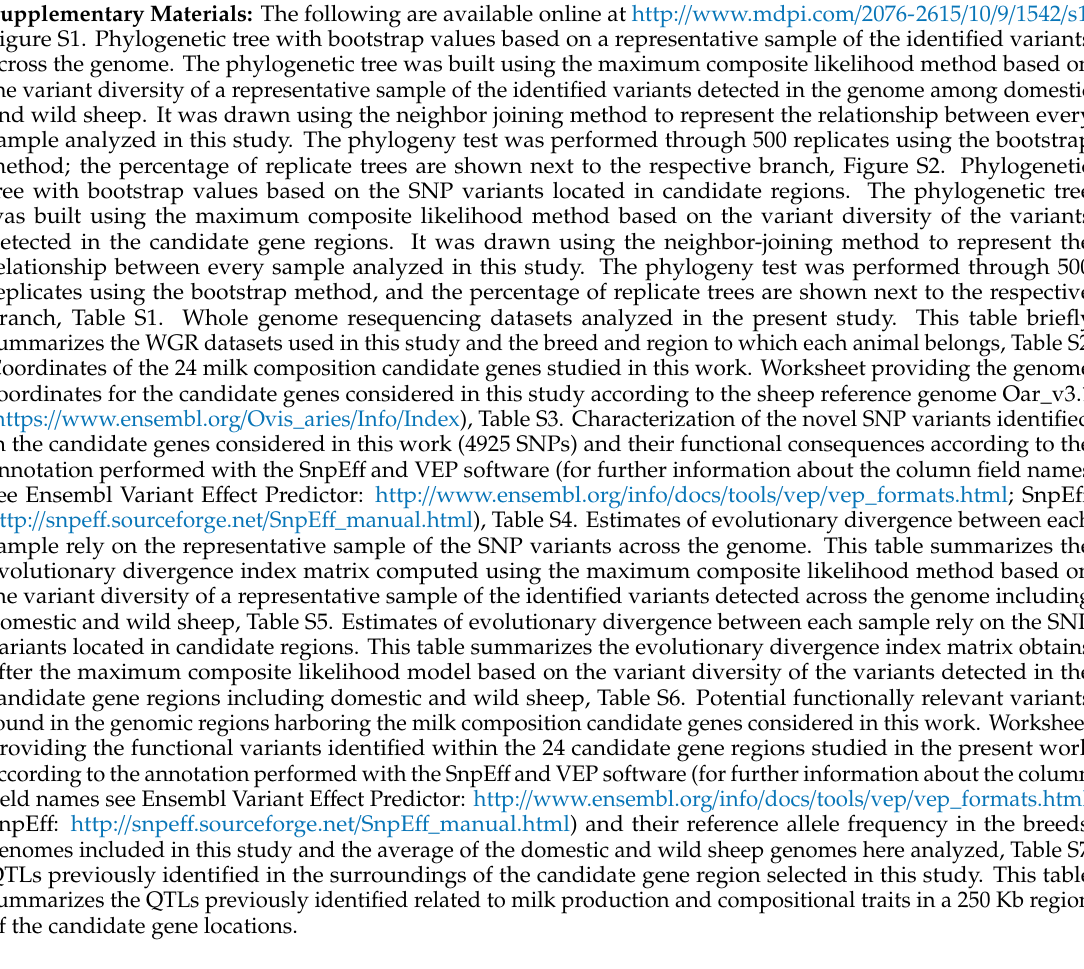
Figure S1. Phylogenetic tree with bootstrap values based on a representative sample of the identified variants across the genome. The phylogenetic tree was built using the maximum composite likelihood method based on the variant diversity of a representative sample of the identified variants detected in the genome among domestic and wild sheep. It was drawn using the neighbor joining method to represent the relationship between every sample analyzed in this study. The phylogeny test was performed through 500 replicates using the bootstrap method; the percentage of replicate trees are shown next to the respective branch, Figure S2. Phylogenetic tree with bootstrap values based on the SNP variants located in candidate regions. The phylogenetic tree was built using the maximum composite likelihood method based on the variant diversity of the variants detected in the candidate gene regions. It was drawn using the neighbor-joining method to represent the relationship between every sample analyzed in this study. The phylogeny test was performed through 500 replicates using the bootstrap method, and the percentage of replicate trees are shown next to the respective branch, Table S1. Whole genome resequencing datasets analyzed in the present study. This table briefly coordinates for the candidate genes considered in this study according to the sheep reference genome